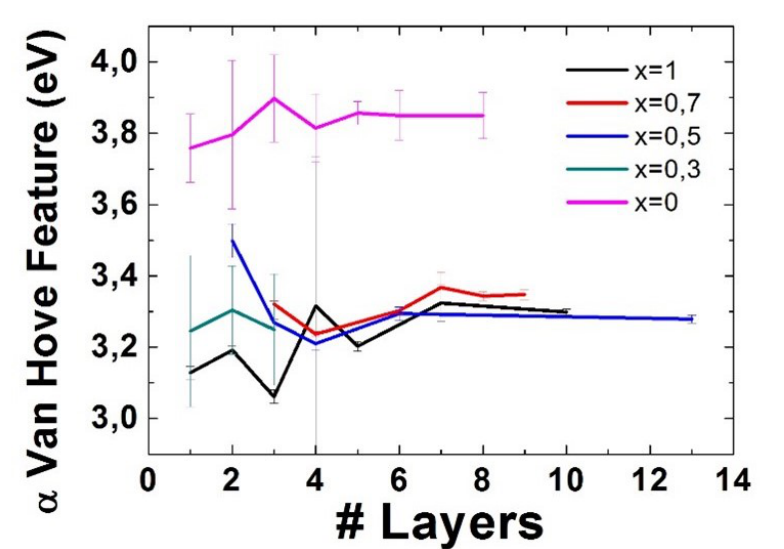
Figure 6. Position of the Gaussian fit corresponding to the α Van Hove feature for different number of layers and different alloying degrees. The error bars represent the error in the Gaussian fit for those layer numbers where only one measurement could be taken, and the standard deviation among measurements for those where several measurements could be